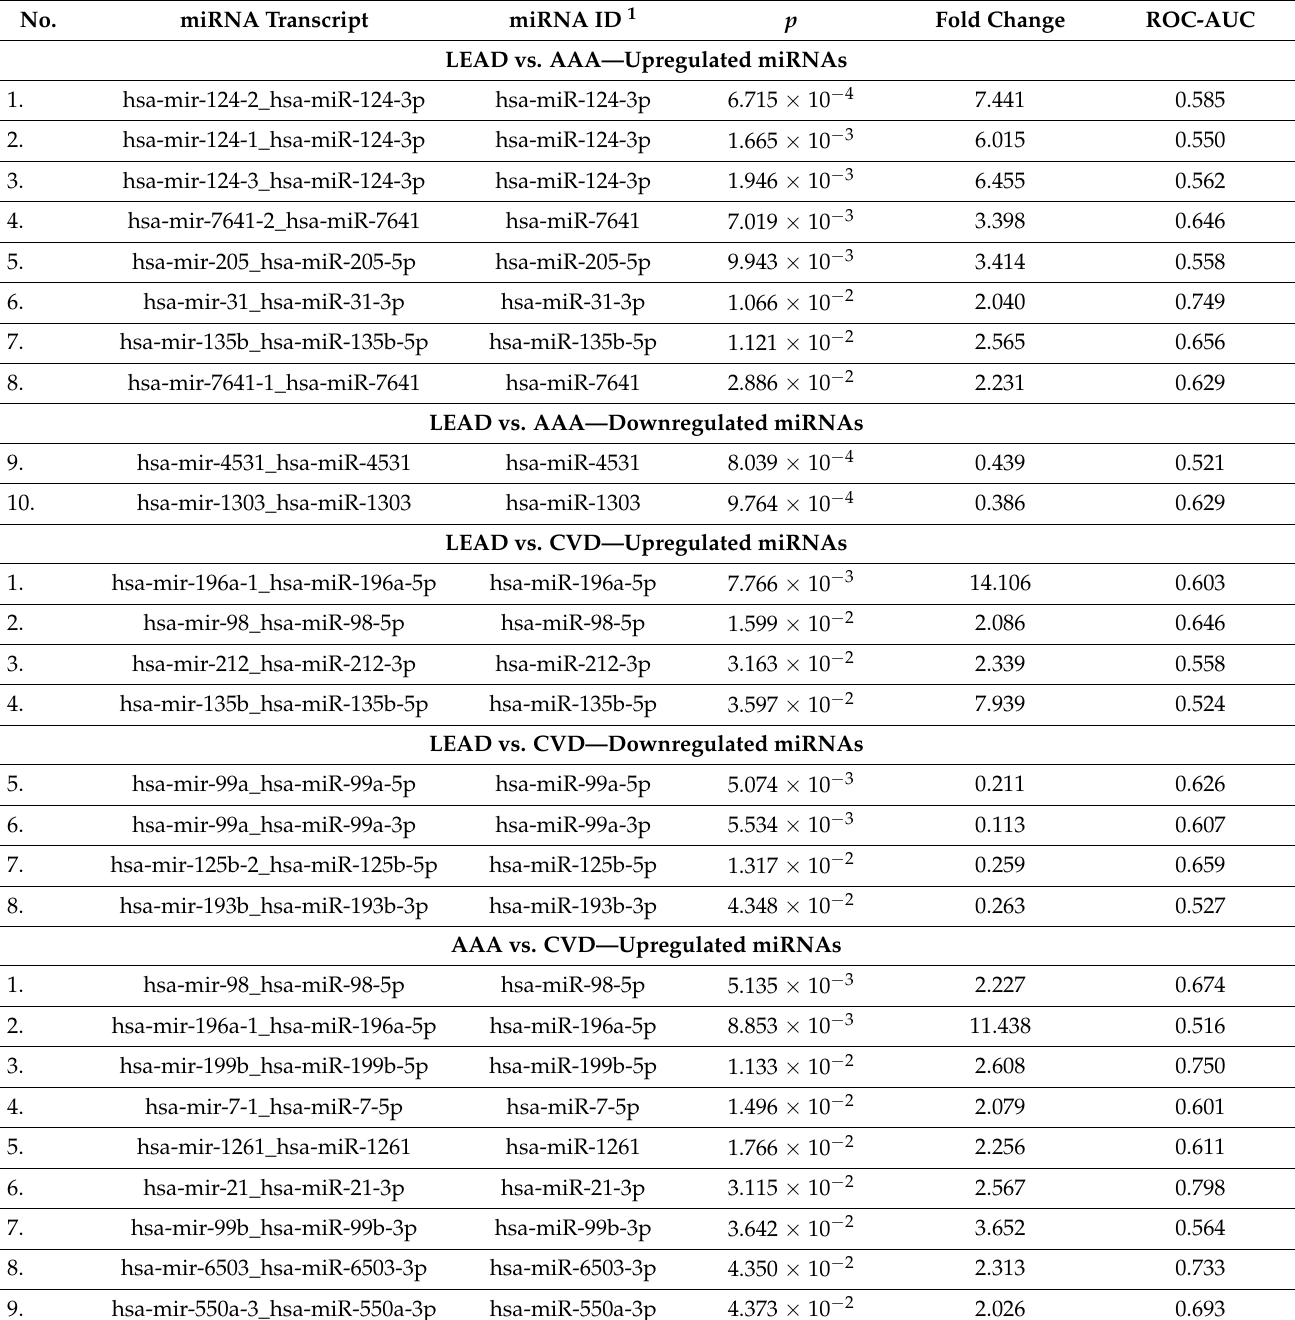
Table 2. Differential expression parameters of 10, 8, and 17 miRNA transcripts selected from LEAD vs. AAA, LEAD vs. CVD, and AAA vs. CVD comparisons,